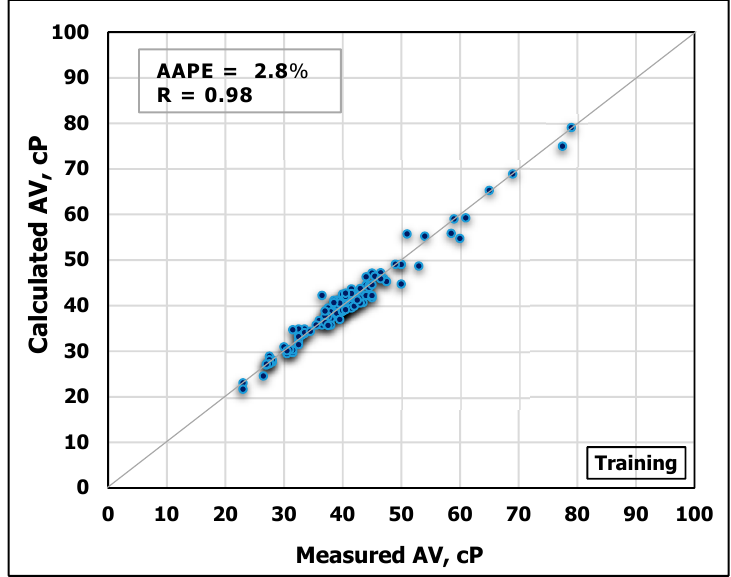
Figure 9. Measured AV vs. Predicted AV from the ANN model for the training process.